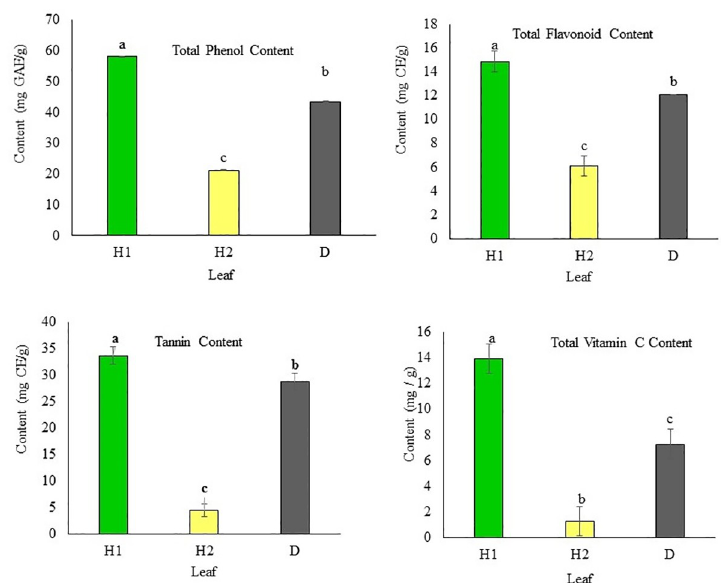
Fig 2. Phenolic compounds and vitamin C content in persimmon leaves. H1: asymptomatic leaf (mid-May); H2: asymptomatic leaf (beginning of September); and D: symptomatic leaves infected with Plurivorosphaerella nawae . Different letters indicate that the means are significantly different at 95% confidence